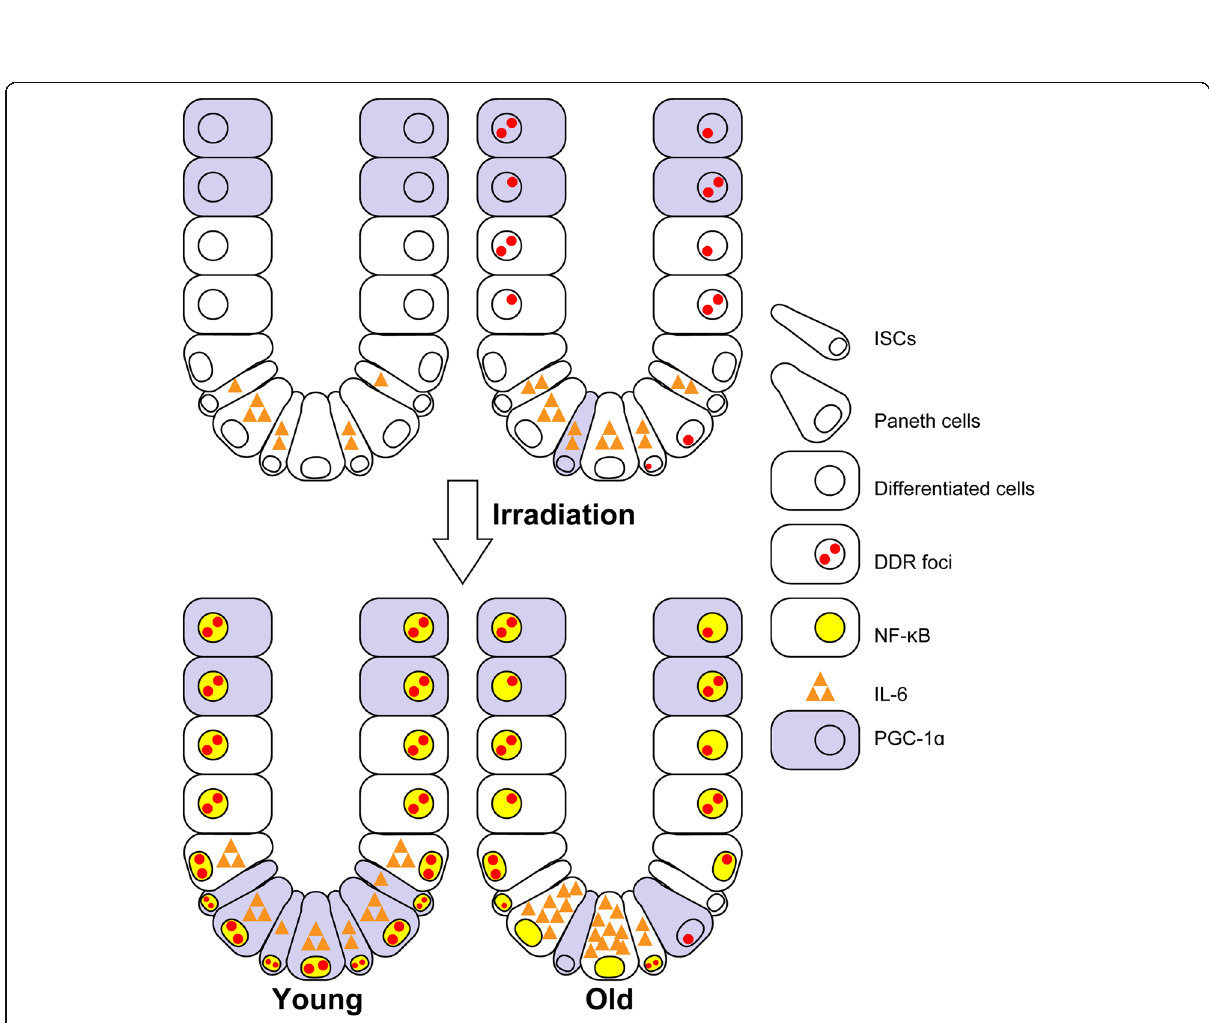
Fig. 4 Schematic diagram of the decreases in the DDR and subsequent inflammation and mitochondrial biogenesis upon irradiation in old